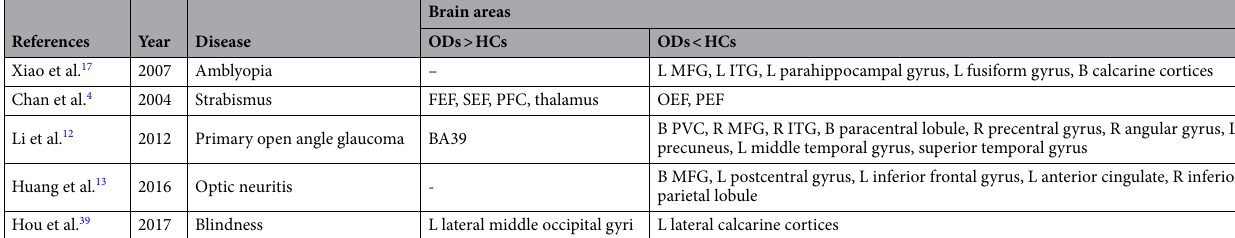
Table 5. VBM method applied in ophthalmological diseases. VBM voxel-based morphometry, OD ophthalmological disease, HC healthy control, L left, R right, B bilateral, MFG left middle frontal gyrus,